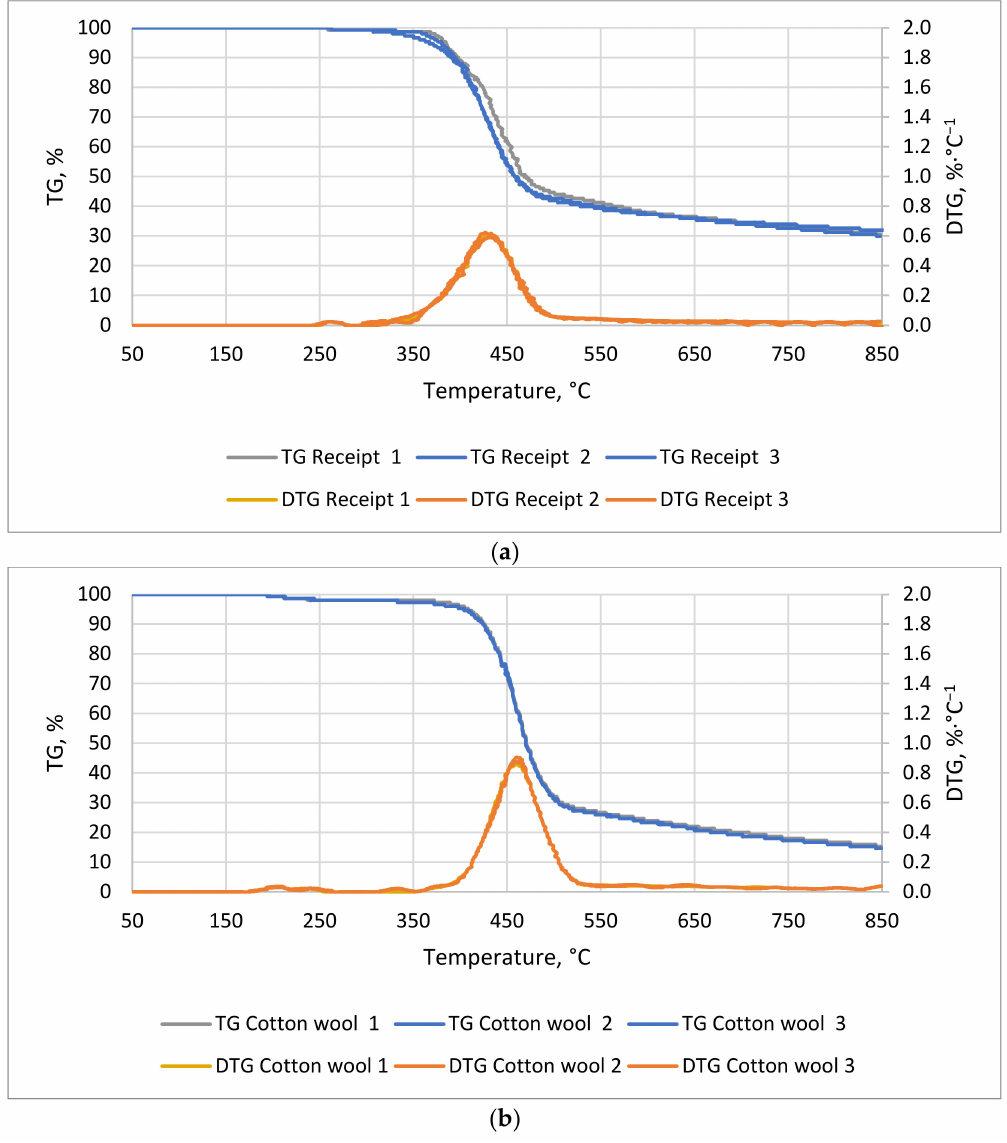
Figure 1. Characteristics of the TG/DTG of paper waste: ( a ) receipts; ( b ) cotton